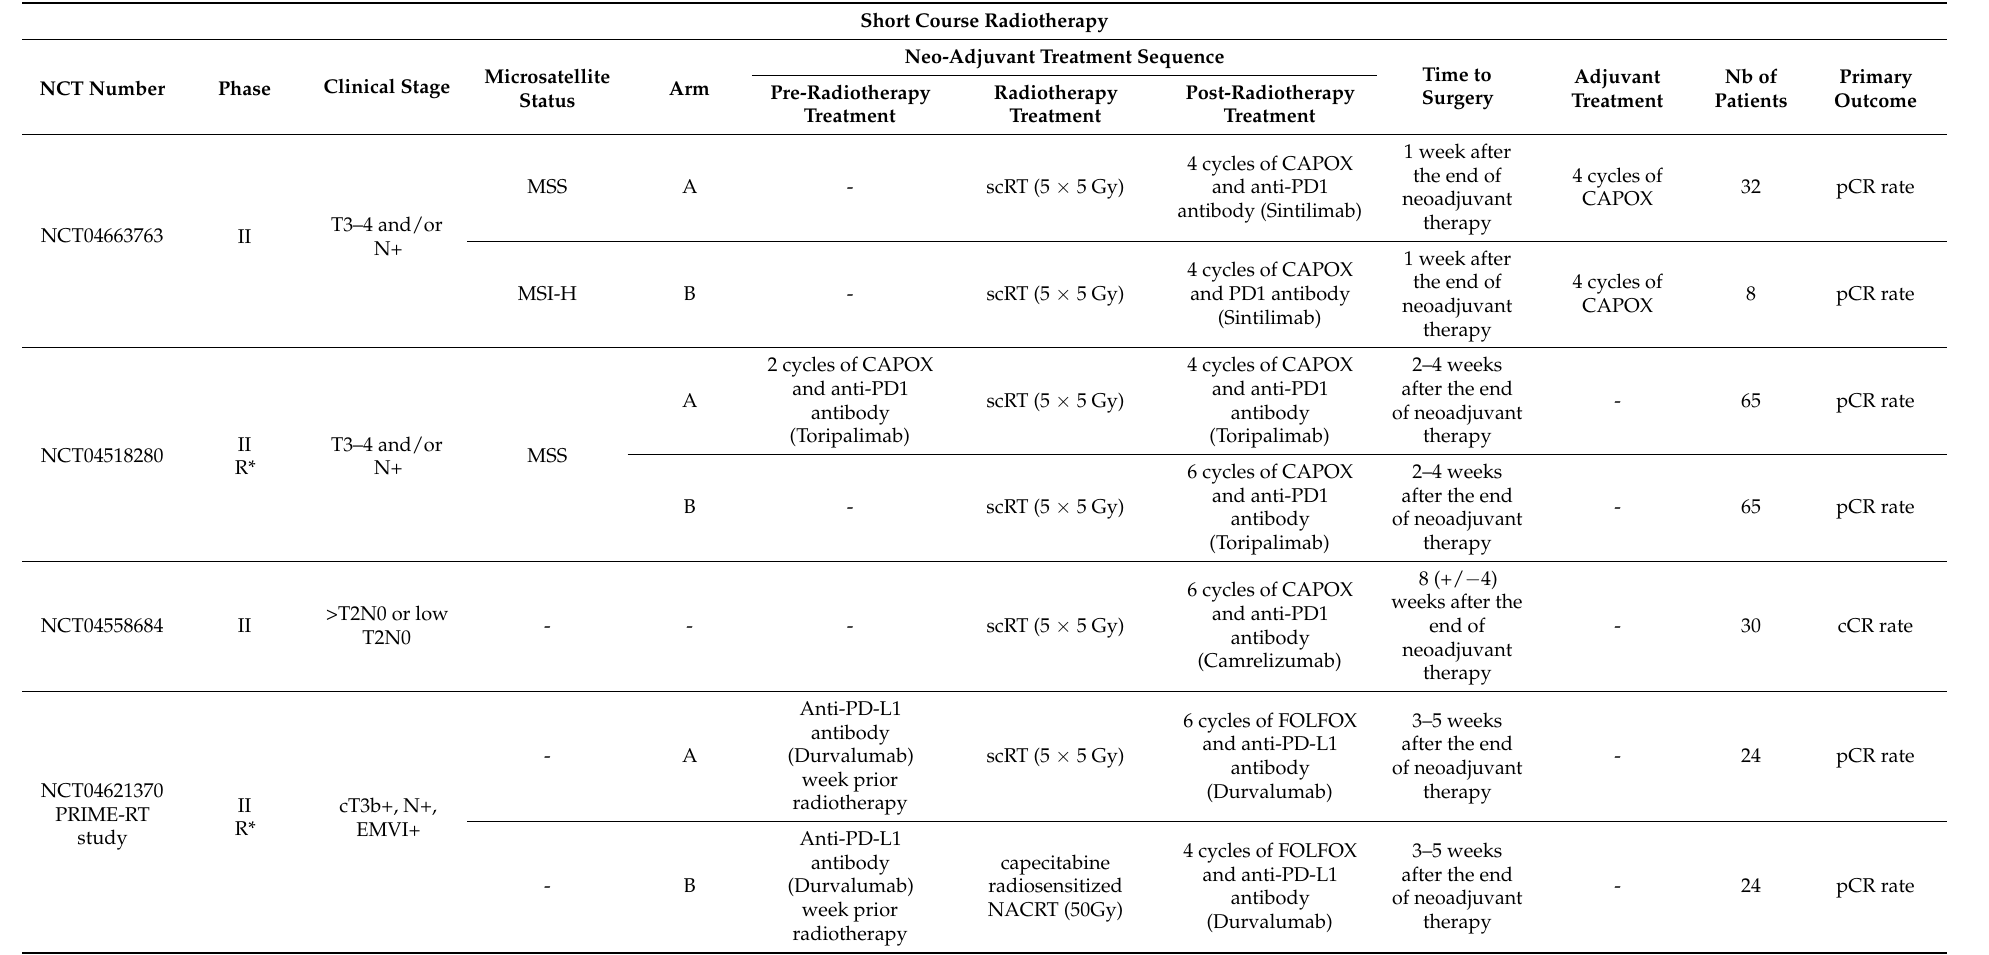
Table 1. Summary of the current clinical trials in the field of radio-immunotherapy in rectal